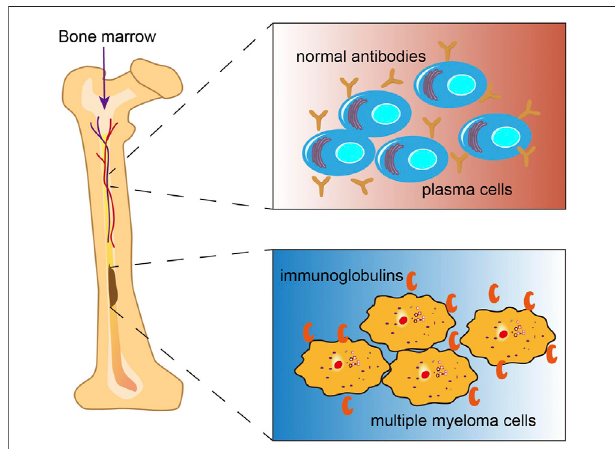
FIGURE 1 | Multiple myeloma (MM). MM is a malignancy of plasma cells originating from the bone marrow, which produces excess monoclonal